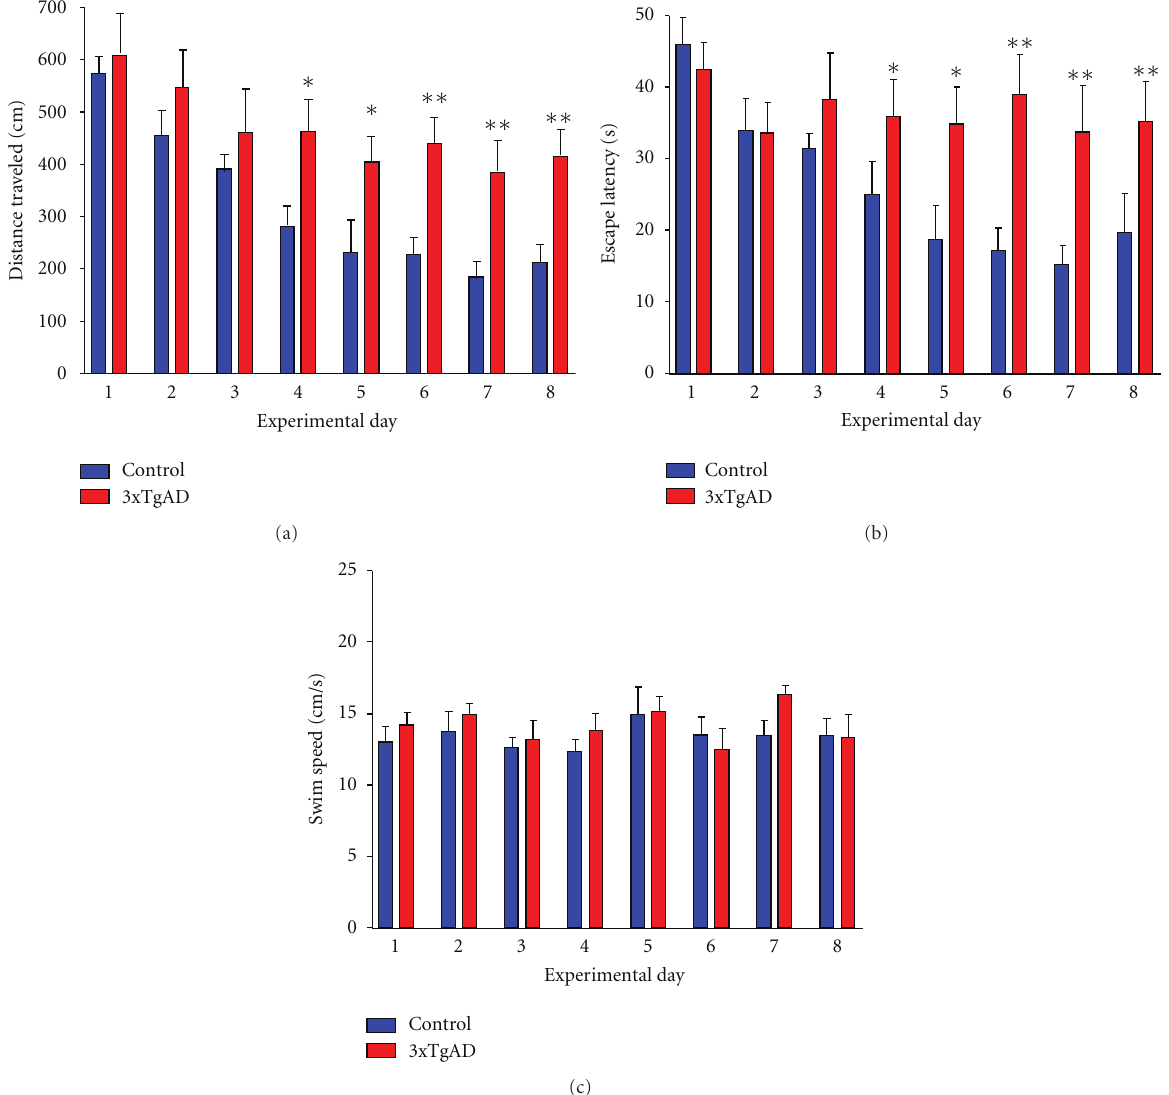
Figure 1: Morris Water Maze testing of control and 3xTgAD mice. (a) Distance travelled (cm) in the nonvisible probe target results for control ( n = 10, blue bars) and 3xTgAD mice ( n = 10, red bars) for 8 days of training. (b) Water maze escape latency (s) for days 1 to 8 of training in the nonvisible probe target. (c) Swim speed (cm/s) assessment of control and 3xTgAD animals during days 1–8 of training. ∗ P < . 05; ∗∗ P < .